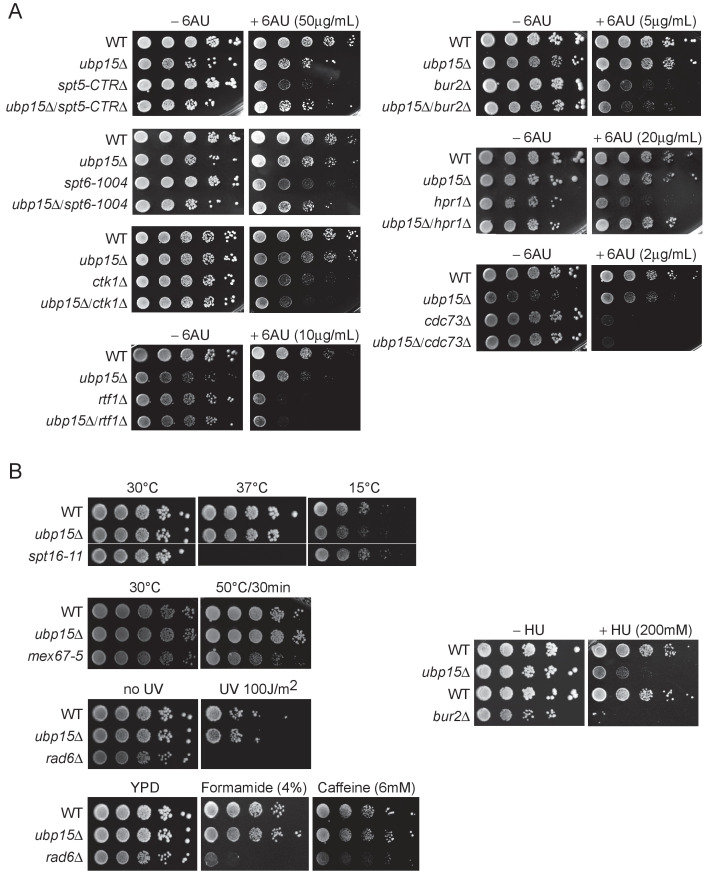
UBP15 deletion phenotypes and genetic interactions.(A) Deletion of UBP15 suppresses the 6AU sensitivity of spt5-CTRΔ, spt6-1004, and hpr1Δ cells but not of bur2Δ, ctk1Δ, rtf1Δ, and cdc73Δ cells. Cells were grown, diluted, and spotted as described for Figure 2A. Note that the 6AU concentration varies and has been optimized for each mutant. (B) Serial-dilution growth assays assessing the sensitivity of WT and ubp15Δ cells to various conditions. Cells were grown to saturation in YPD medium, washed, resuspended at the same density in water, serially diluted (fivefold series), and spotted on the indicated media. For growth at 37°C and 15°C, spt6-11 was used as a positive control. For heat-shock, plates were placed for 30 min at 50°C before incubation at 30°C and mex67-5 was used as a positive control. For ultraviolet light (UV), the plates were subjected to the indicated doses of UV (UV Stratalinker 1800) right after spotting and rad6Δ was used as a positive control. For hydroxyurea (HU), bur2Δ was used as a positive control. For formamide and caffeine, rad6Δ was used as a positive control.